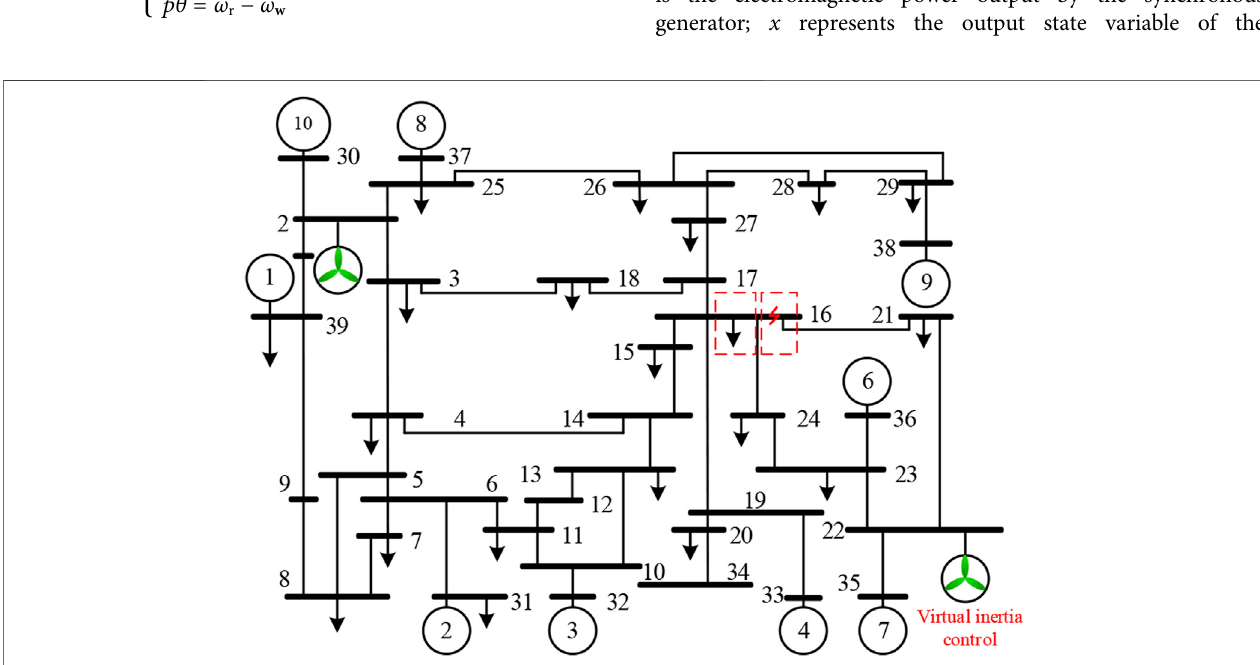
FIGURE 3 | Diagram of the simulation system with the wind